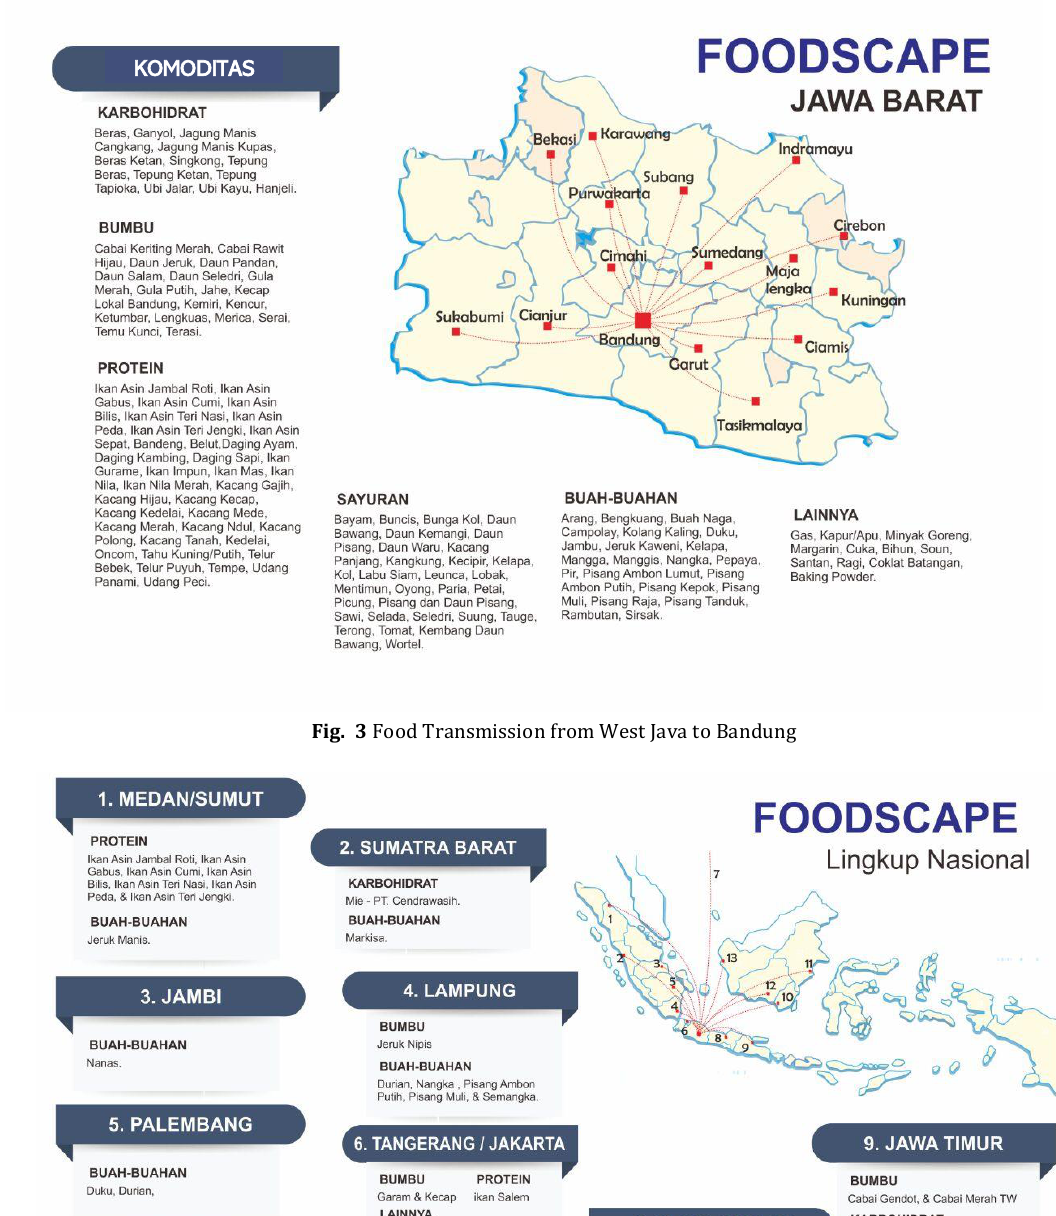
Fig. 4 Food Transmission from Other Region to